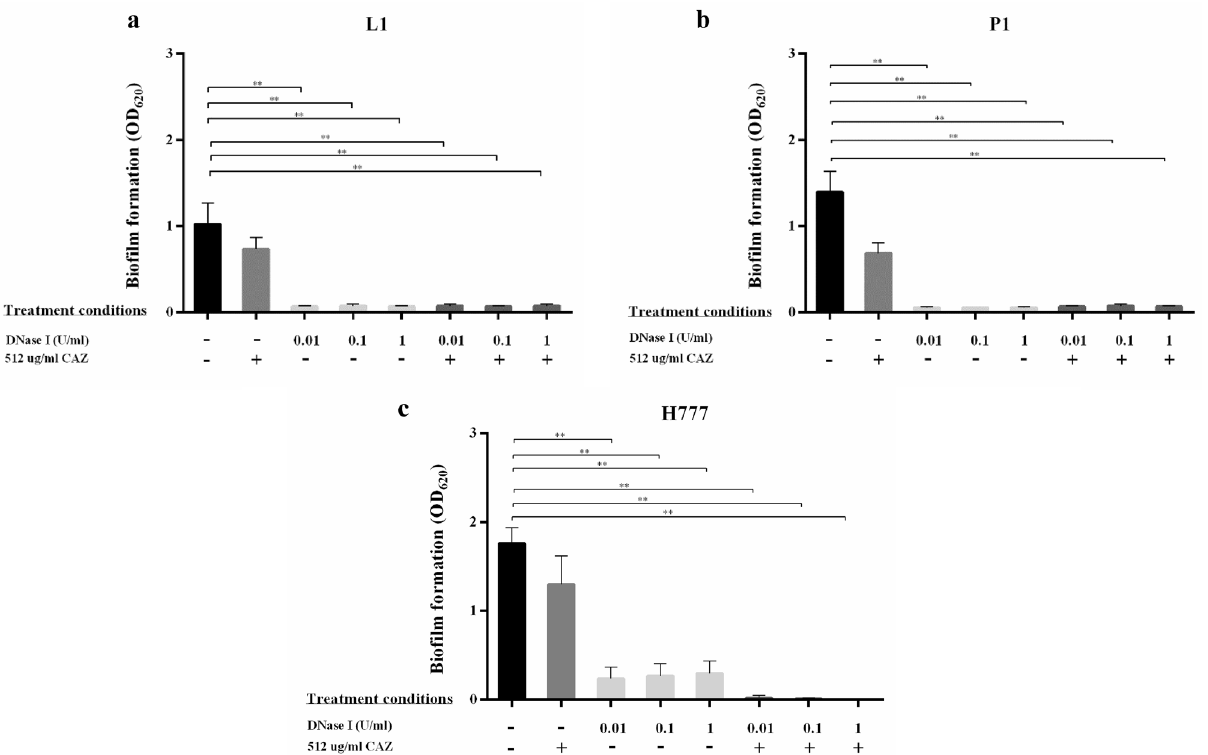
Figure 1. DNase I combined with ceftazidime inhibits B. pseudomallei biofilm formation. Burkholderia pseudomallei L1 ( a ), P1 ( b ) and H777 ( c ) were grown on pegs in 96-well plates in the presence of 0.01, 0.1 or 1 U/mL DNase I for the first 24 h. Subsequently, 512 µg/mL CAZ was added into the cultures for another 24 h. The 2-day biofilm formation was examined using crystal-violet staining. The experiment was performed in duplicate in each of three independent experiments. ** p <